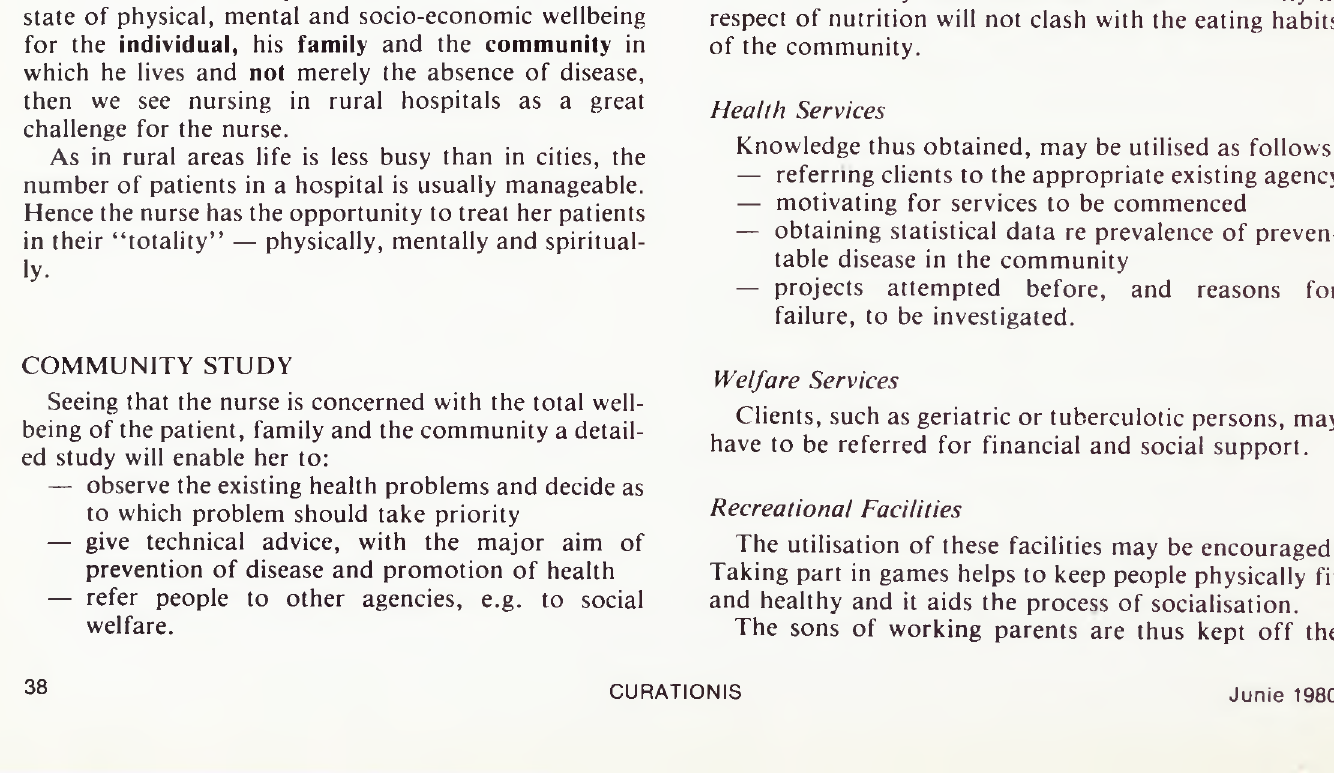
table disease in the